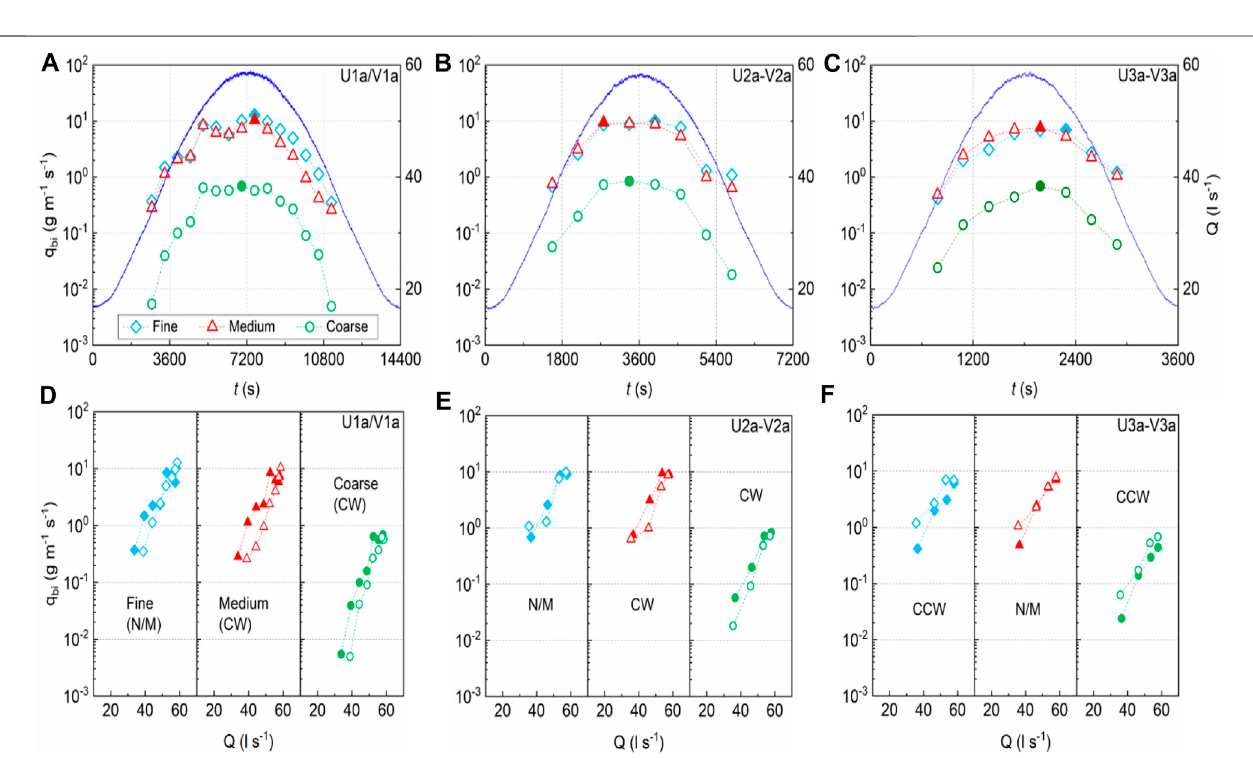
FIGURE 4 | (A – C) Illustrative plots showing temporal variation in fl ow rate Q and fractional bed load transport rates q bi (for fi ne F , medium M and coarse C size classes),and (D – F) q bi :Q phaseplotsshowingrepresentativehysteresispatterns forhydrographruns (A,D) U1a(V1a); (B,E) U2a-V2aand (C,F) U3a-V3a(see Table1 ).